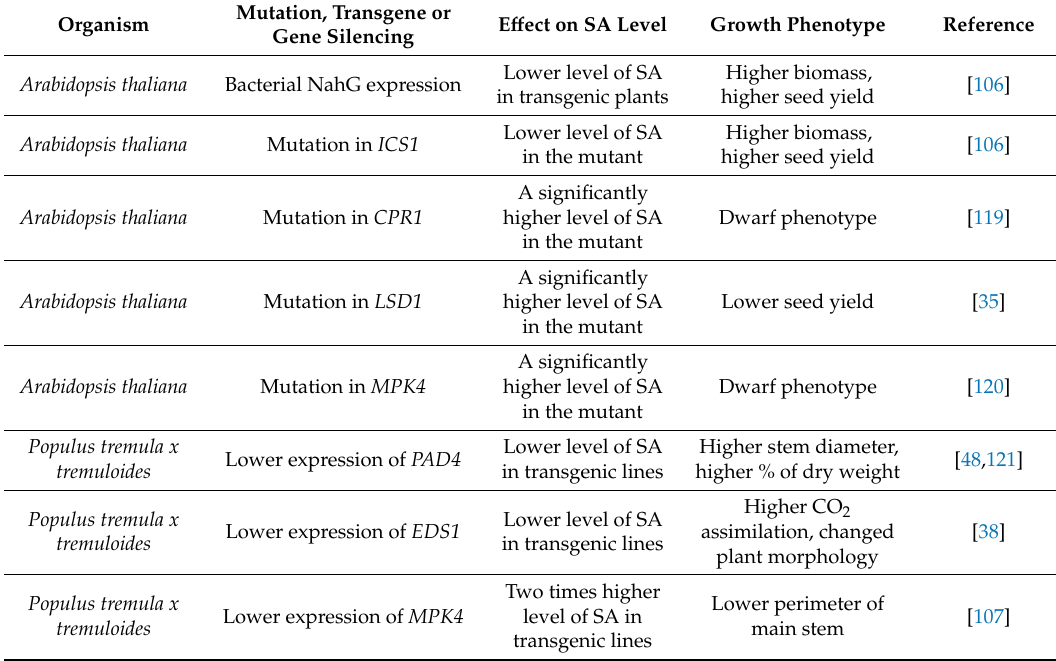
Table 1. E ff ect of mutation, gene silencing or bacterial genes expression in plant on SA level and plant